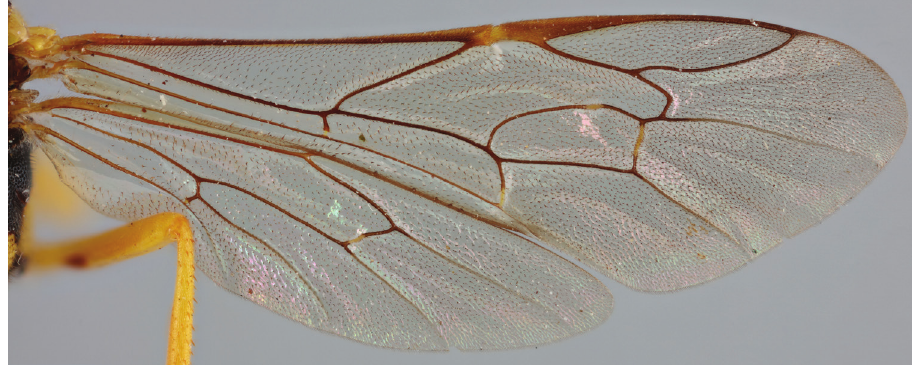
Figure 5. Hellwigia elegans , wings (Cyprus).